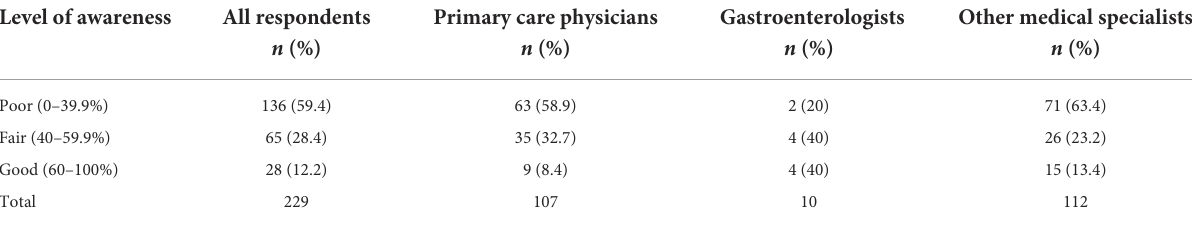
TABLE 2 Level of awareness of